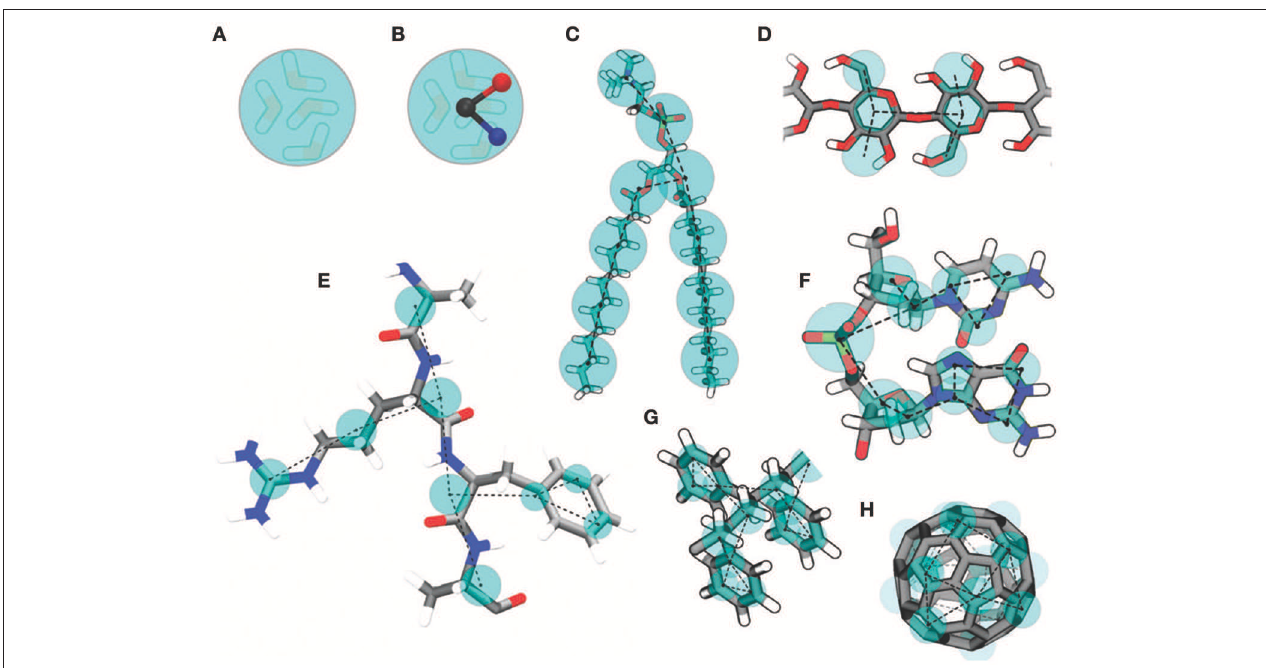
FIGURE 1 | Examples of MARTINI mapping. Standard water bead embedding four water molecules (A) . Polarizable water bead with embedded charges (B) . DMPC lipid (C) . Polysaccharide fragment (D) . Peptide (E) . DNA fragment (F) . Polystyrene fragment (G) . Fullerene (H) . Reproduced from Marrink and Tieleman (2013) under a CC-BY 3.0 license. Published by the Royal Society of